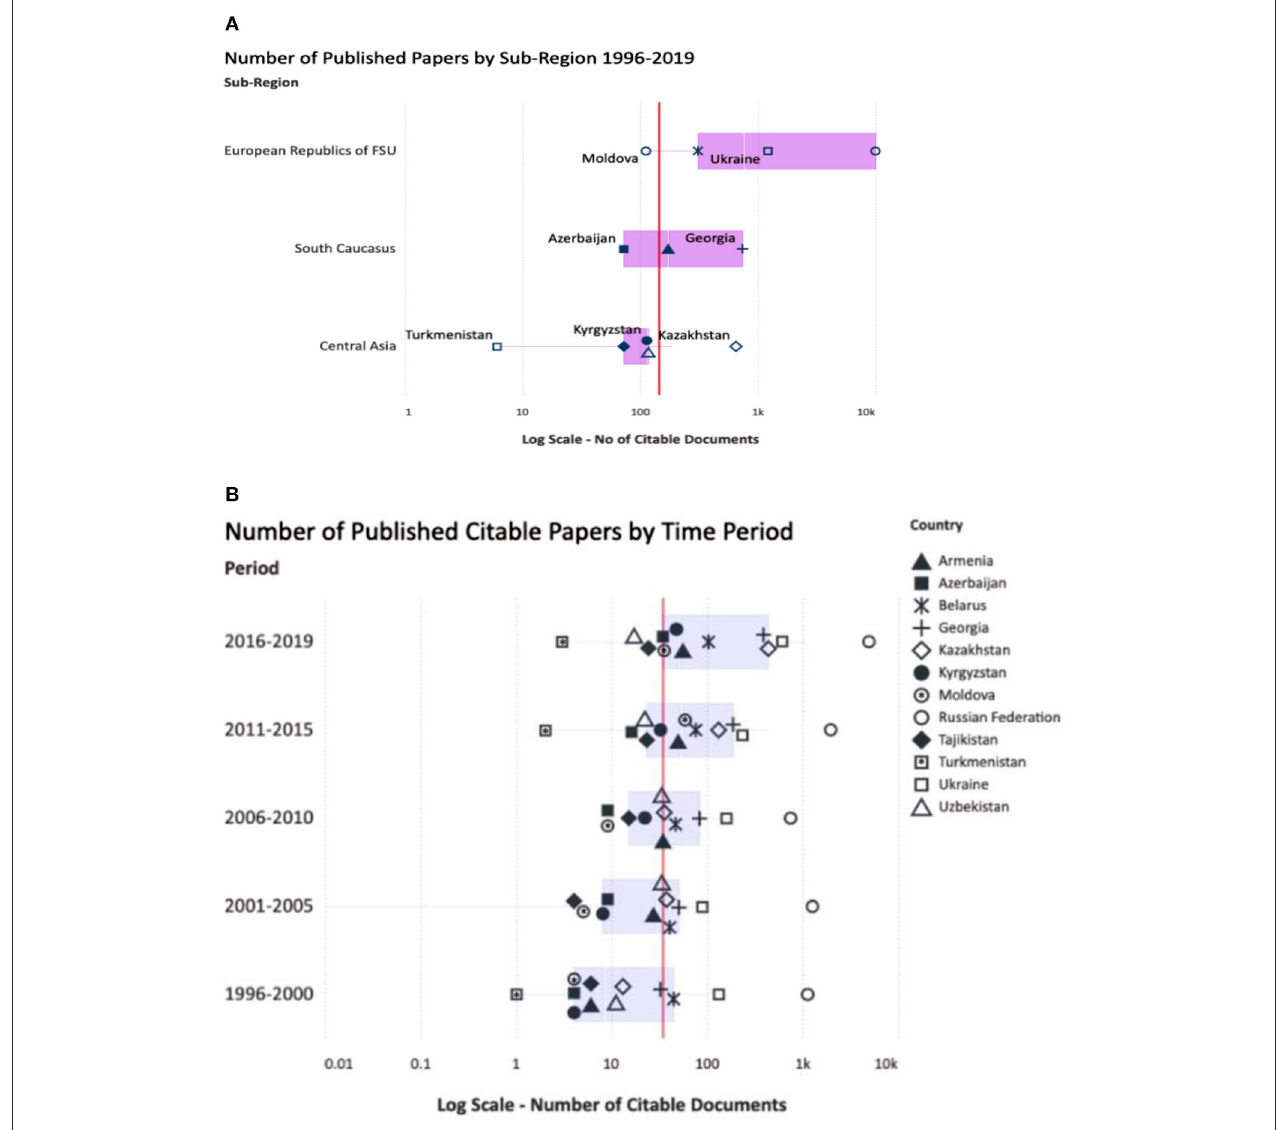
FIGURE 1 | (A) Published citable articles in Web of Science database during 1996–2019 by sub-regions and (B) number of published citable articles by the time about